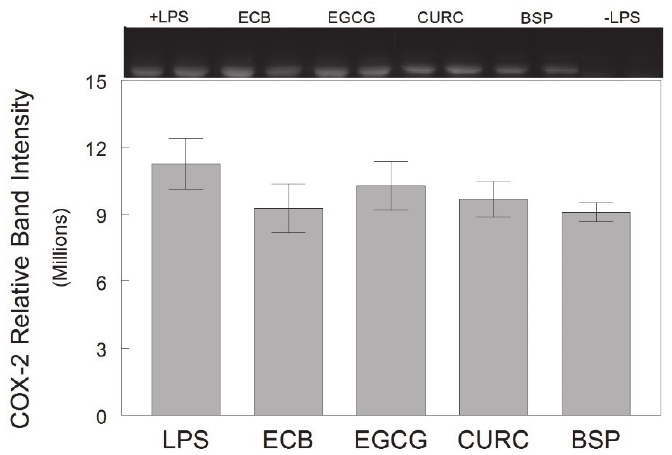
Figure 6. Expression of COX-2 in HAPI rat microglial cells pre-treated with ECB or its component phytochemicals (EGCG, CURC, BSP) and stimulated 18 h overnight with LPS (100 ng/mL). Data are expressed as mean ± SEM of the immunoreactive band density per 20 µ g total protein as measured by Western blot (top). Each pre-treatment was compared against LPS alone and individual components compared to ECB. LPS = lipopolysaccharide only; ECB = combination compound; EGCG = epigallocatechin gallate; CURC = curcumin; BSP = broccoli sprouts; − LPS = no LPS.